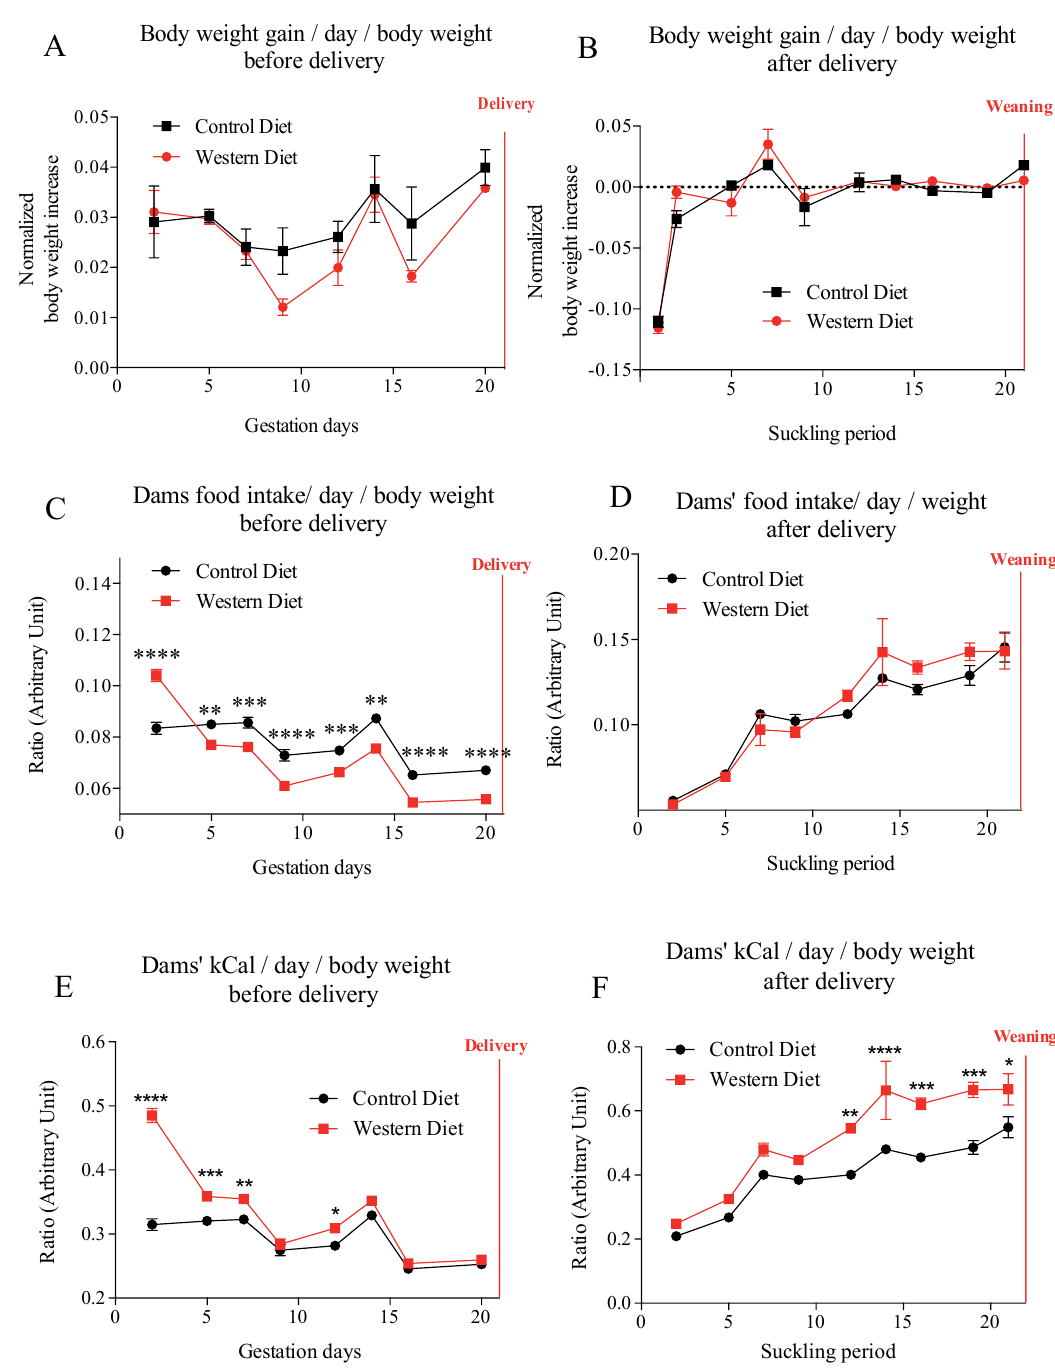
Figure 1. Dams’ body weight gain ( A , B ), food intake ( C , D ) and dams’ kcal intake ( E , F ) during gestation and lactation. Values of p -values (assessed by Mann–Whitney U test) between “western diet” and “control diet” groups were reported with *, **, ***, ****, significantly di ff erent; p < 0.05, p < 0.01, p < 0.001, or p < 0.0001,